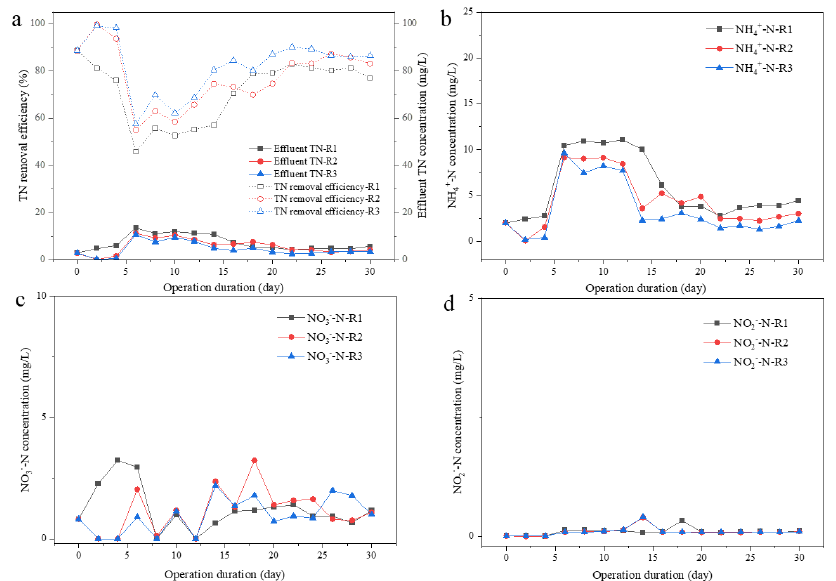
Figure 4. Effluent nitrogen concentrations and TN removal efficiency. Effluent TN and TN removal efficiency ( a ), effluent ammonia nitrogen (NH 4+ − N) ( b ), effluent nitrate nitrogen (NO 3 − − N) ( c ), and effluent nitrite nitrogen (NO 2 − − N) ( d ) concentrations.